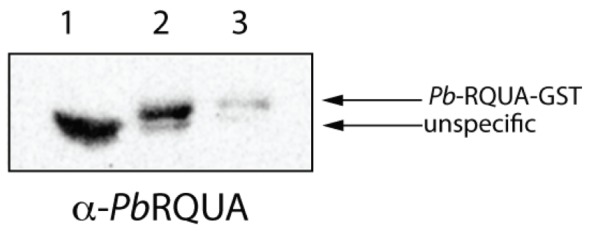
Antibodies directed against Pygsuia RquA (PbRquA) recognize purified recombinant PbRquA by western blot analysis.Proteins isolated from whole cell extracts of E. coli induced to express pGEX4T-1 (1) and pGEX- Pb-rquA (2) and glutathione-S-transferase(GST)-Pb-rquA purified with glutathione magnetic beads (3) were resolved by SDS-PAGE and probed by immunoblotting using anti- PbRquA. The estimated molecular weight of the GST-PbRquA is 56 kDa (i.e., 26 kDa GST and 30 kDa for PbRquA). The antibody interacted with an endogenous E. coli protein (1 and 2, lower signal) and this signal was mostly reduced upon purification of the protein (3).